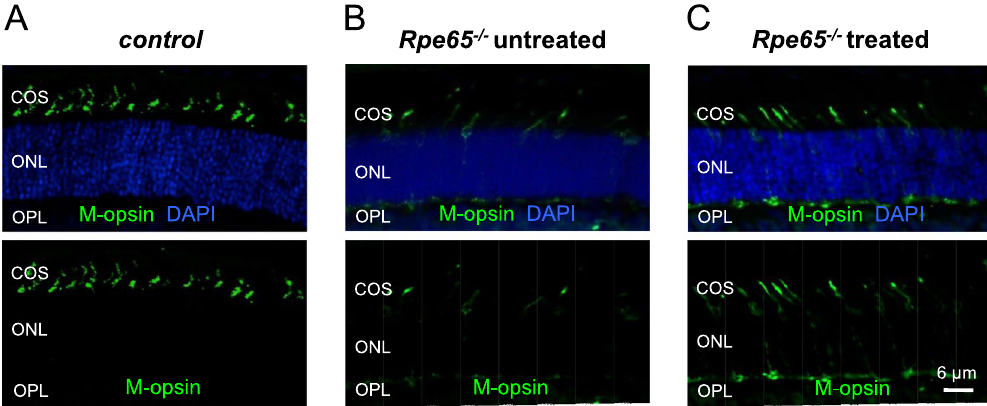
Figure 3. Chromophore treatment corrects the localization of M-cone opsin and the structure of cone outer segments in RPE65-deficient mice. M-opsin immunolocalization (green) in the dorsal retina of control Rpe65 + / + Gnat1 − / − ( A ), uninjected Rpe65 − / − Gnat1 − / − animals ( B ), and Rpe65 − / − Gnat1 − / − mice injected with Matrigel loaded with 9- cis -retinal ( C ). COS: cone outer segments; ONL: outer nuclear layer; OPL: outer plexiform layer. Cell nuclei were stained with DAPI (blue). Scale bar, 6 μ